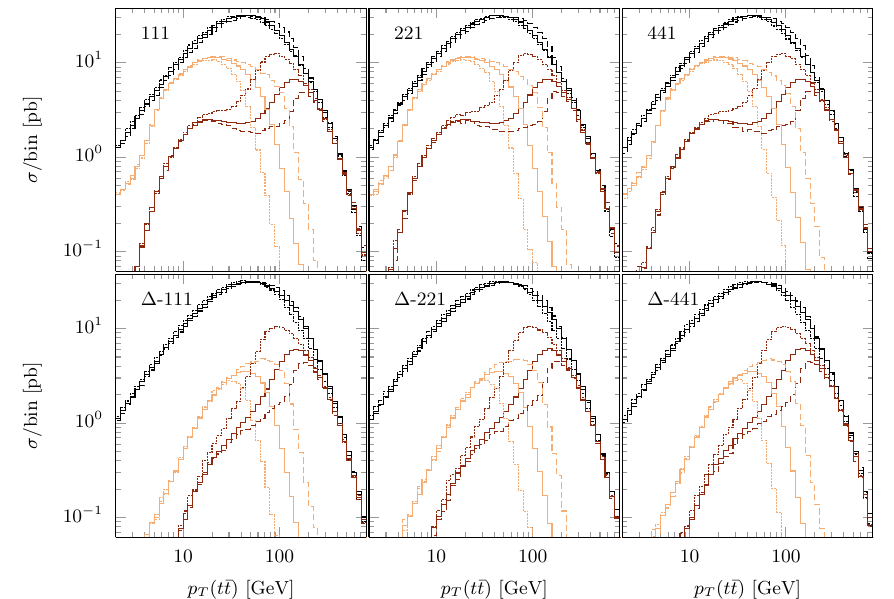
Figure 6 . Transverse momentum of the t (cid:22) t pair, after parton showers (black histograms), and before parton showers for positive-weight (dark brown histograms) and negative-weight (light brown histograms) events; see the text for